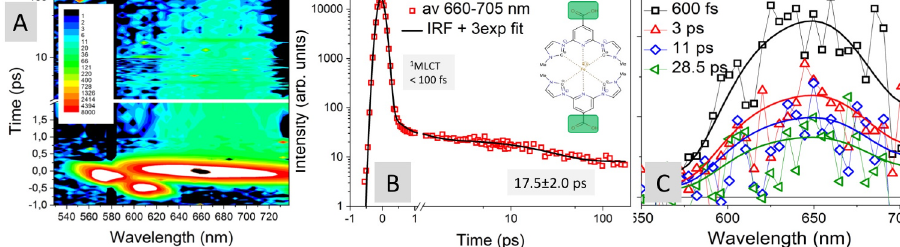
Figure 1: Emission data of the Fe(II)-NHC complex in C 2 H 3 N (inset fig. 1B) measured by the high- sensitivity FLUPS experiment. (A): 2D map of time-and wavelength-resolved data. (B) Kinetic trace of the emission obtained by integrating the intensity over 660 to 705 nm. (C) Time-resolved emission spectra for the delays indicated. Solid lines are guide - to - the -